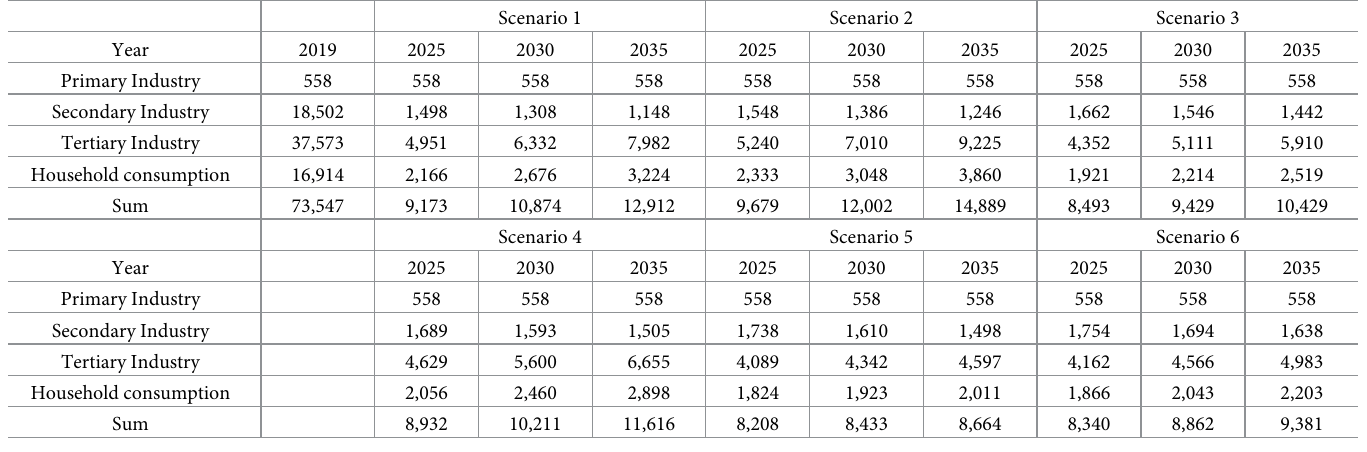
Table 7. Forecast value of terminal energy consumption by industry based on elasticity coefficient method